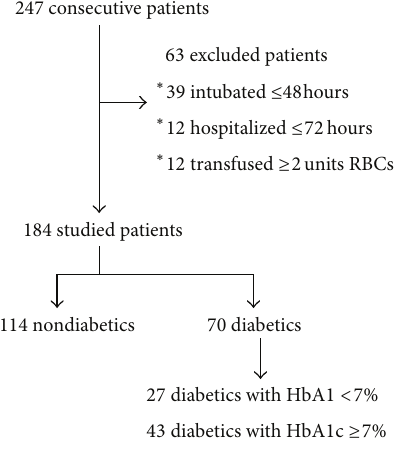
Figure 1: Flow chart of the